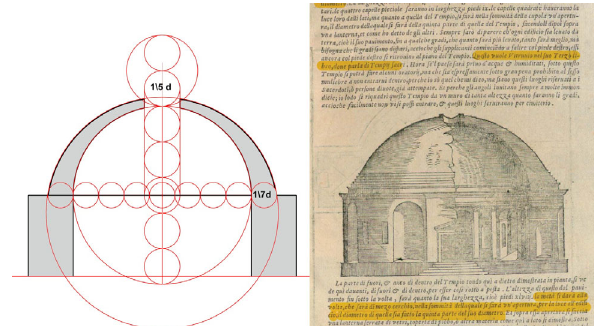
Figure 2. Sebastiano Serlio, Sette libri di Architettura, Libro V,